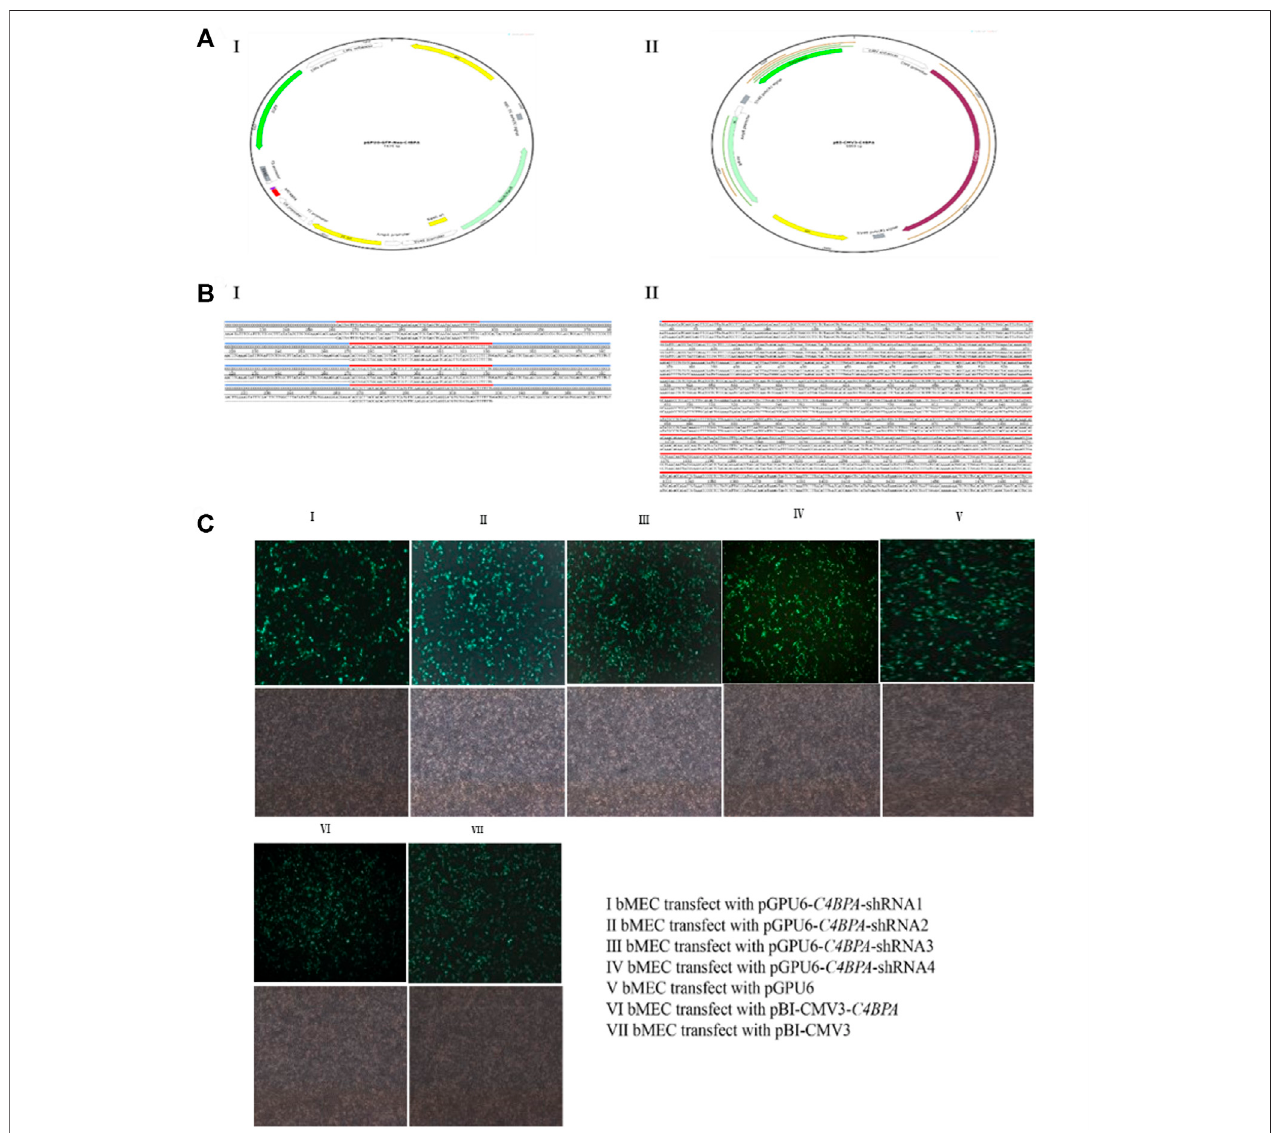
FIGURE 1 | Construction of C4BPA gene interferences and overexpression vector. (AI) Construct an interference vector map. (AII) Construct C4BPA overexpressionvectormap. (BI) pGPU6- C4BPA -shRNA1,pGPU6- C4BPA -shRNA2,pGPU6- C4BPA -shRNA3,andpGPU6- C4BPA -shRNA4fourinterferencesvector sequences. (BI) pBI-CMV3- C4BPA sequencing. (CI) bMECs transfected with pGPU6- C4BPA -shRNA1. (CII) bMECs transfected with pGPU6- C4BPA -shRNA2. (CIII) bMECs transfected with pGPU6- C4BPA -shRNA3. (CIV) bMECs transfected with pGPU6- C4BPA -shRNA4. (CV) bMECs transfected with pGPU6. (CVI) bMECs transfected with pBI-CMV3- C4BPA . (CVII) bMECs transfected with